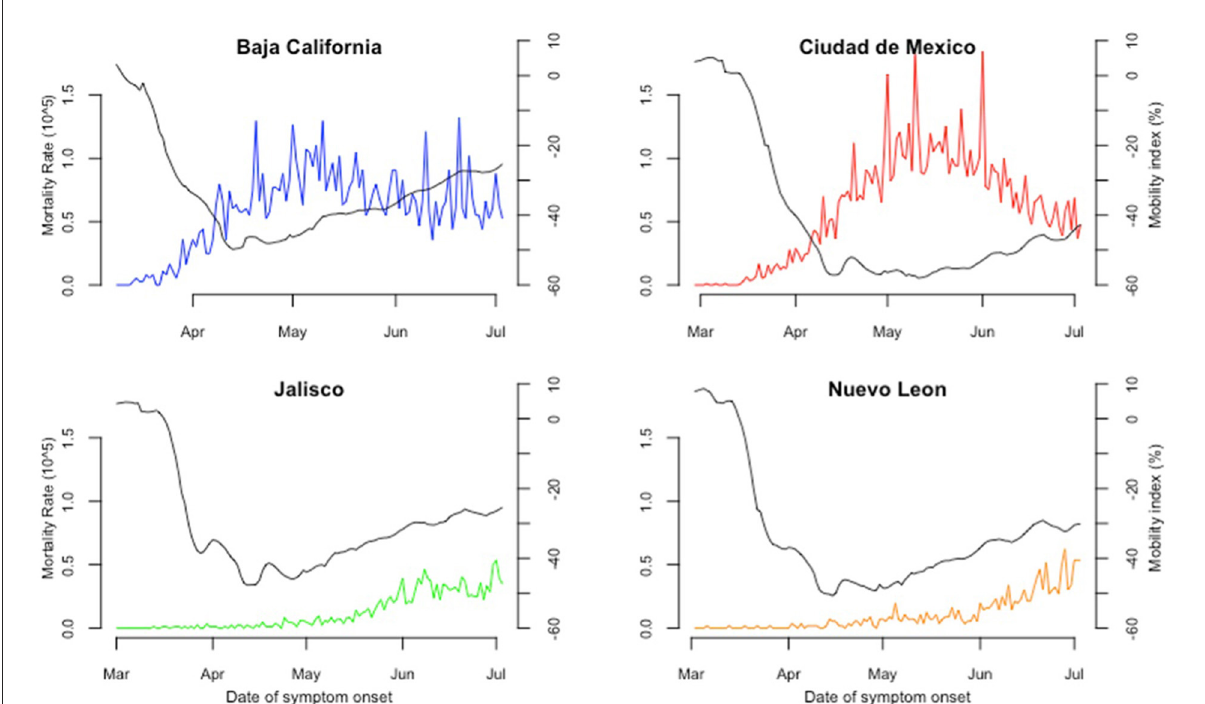
FIGURE4 Mortality rate and mobility index in four states of Mexico from February 28th to July 3rd. The horizontal axis depicts the period covered since the confirmation of the first COVID-19 case in Mexico, February 28th, 2021, to July 3rd 2021. The left vertical axis shows the mortality rate, 0–1.5 confirmed COVID-19 deaths per 100,000 habitants, and the right vertical axis shows the percentage change for mobility in a 10 to − 60% range. The continuous black line represents the average daily mobility rate documented by Google. The colored line shows daily confirmed cases based on their date of symptom